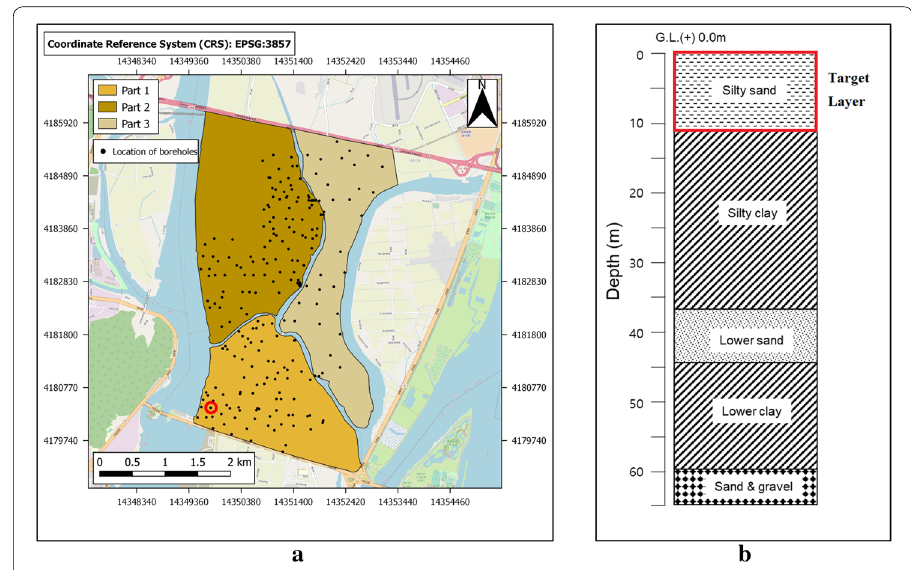
Fig. 5 a The location of boreholes, and b Typical representative soil